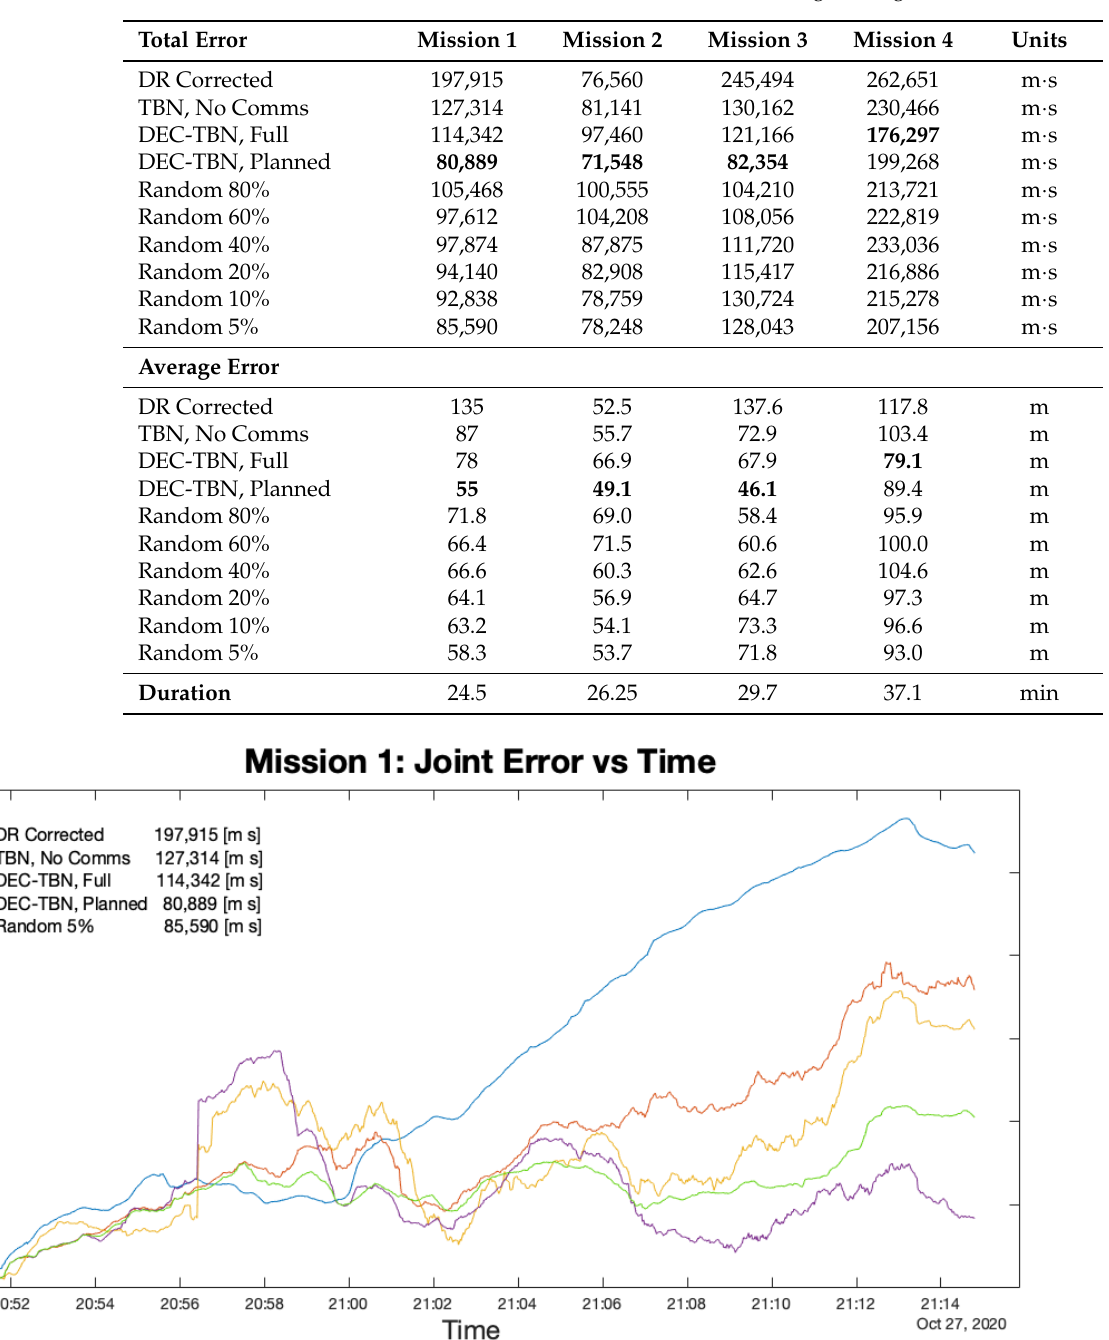
Table 6. Localization results from Foster Reservoir field trials. Path lengths range from 1.1 to 1.6 km.